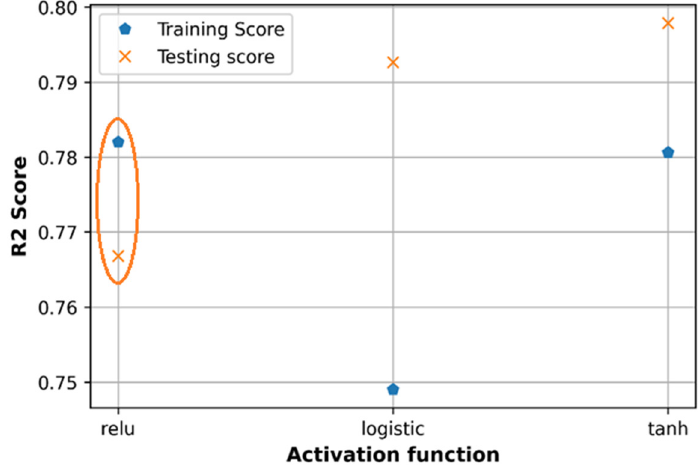
Figure 18. Comparison of accuracy with different activation functions.